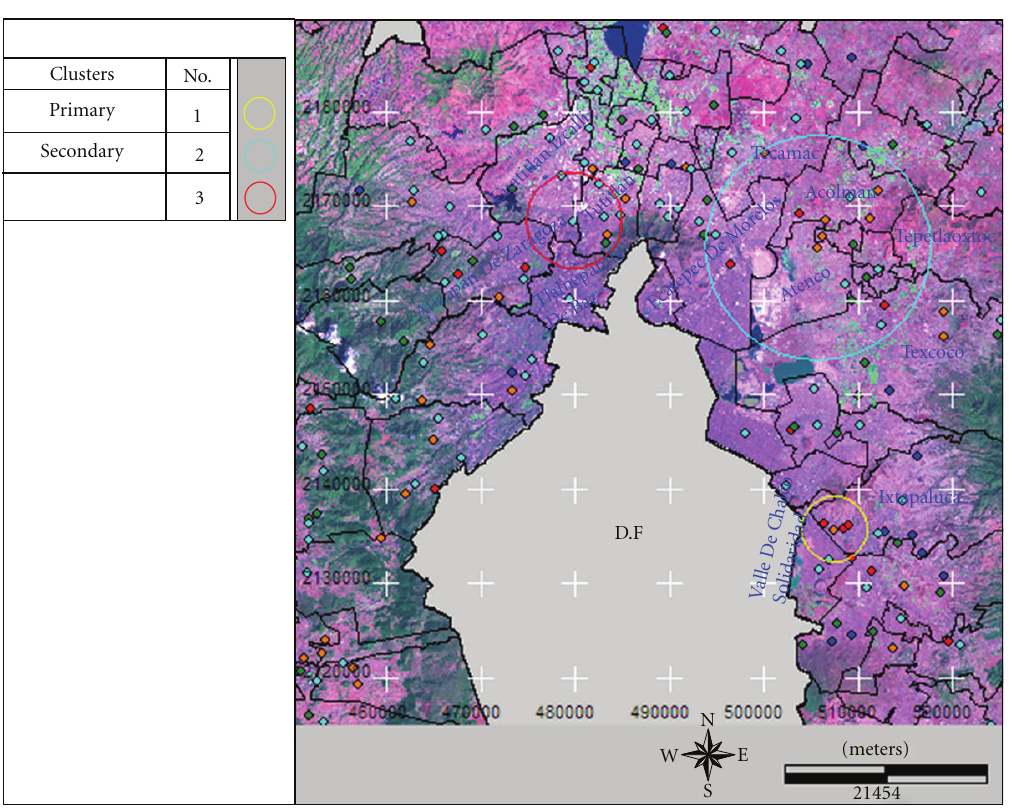
a Locations with TB cases, b Observed number of cases in cluster, c Expected number of cases in cluster, d Relative risk of the cluster, e Log likelihood ratio. ∗ Cluster detected with a search window maximum length of ≤ 50% risk population.